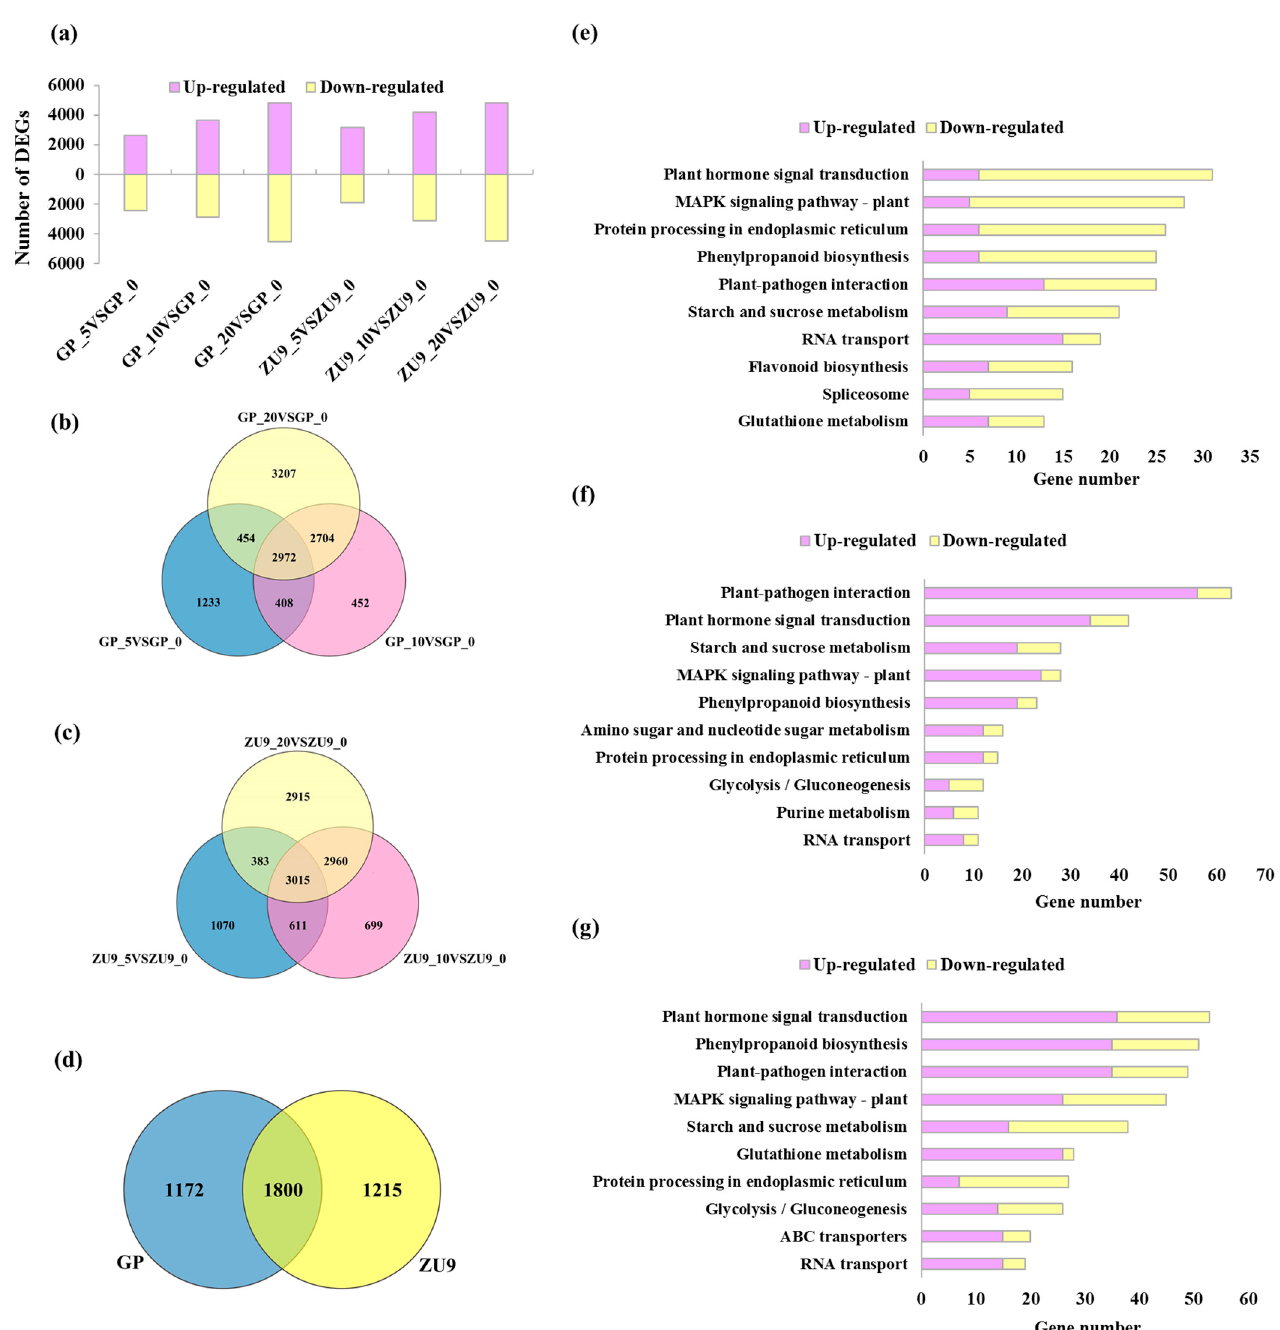
Figure 2. Summary of DEGs identified from the different samples. ( a ) The number of DEGs in the samples taken at different time. ( b ) DEGs in the GP calli at different times. ( c ) DEGs in ZU9 calli at different times. ( d ) Overlapped genes in GP and ZU9 calli. ( e ) The top 10 KEGG pathway categories in GP-specific DEGs. ( f ) The top 10 KEGG pathway categories in ZU9-specific DEGs. ( g ) The top 10 KEGG pathway categories in the common